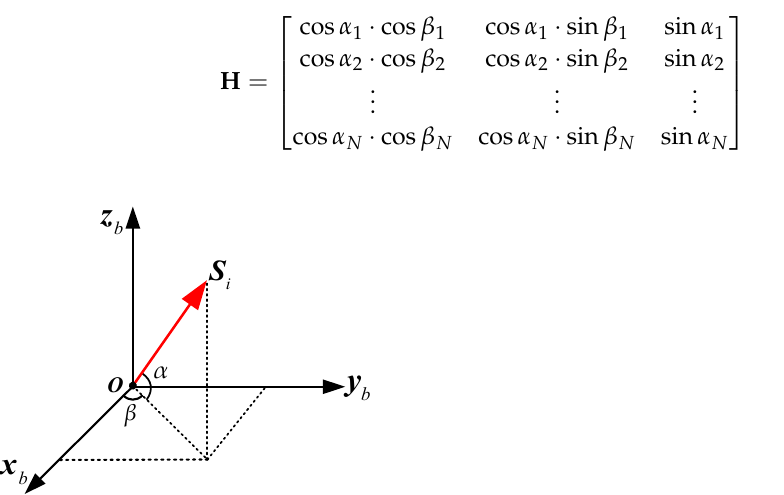
Figure 4. Redundant MIMU signal fusion using a discrete-time KF implementation.